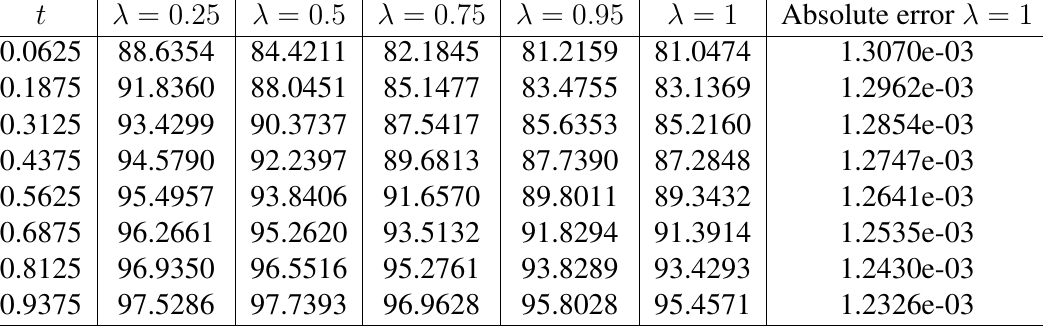
Table 2: The achieved absolute errors and numerical solutions of Example 4.2 using the proposed strategy for J = 2 and T = 1